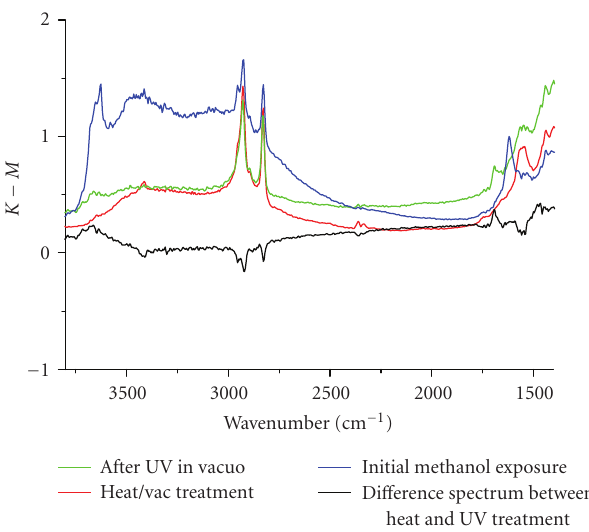
Figure 2: DRIFT spectra of TiO 2 powder heated and irradiated in vacuo after absorbing methanol vapor, and the di ff erence spectrum showing the e ff ect of irradiation on the surface which had already undergone heat treatment.